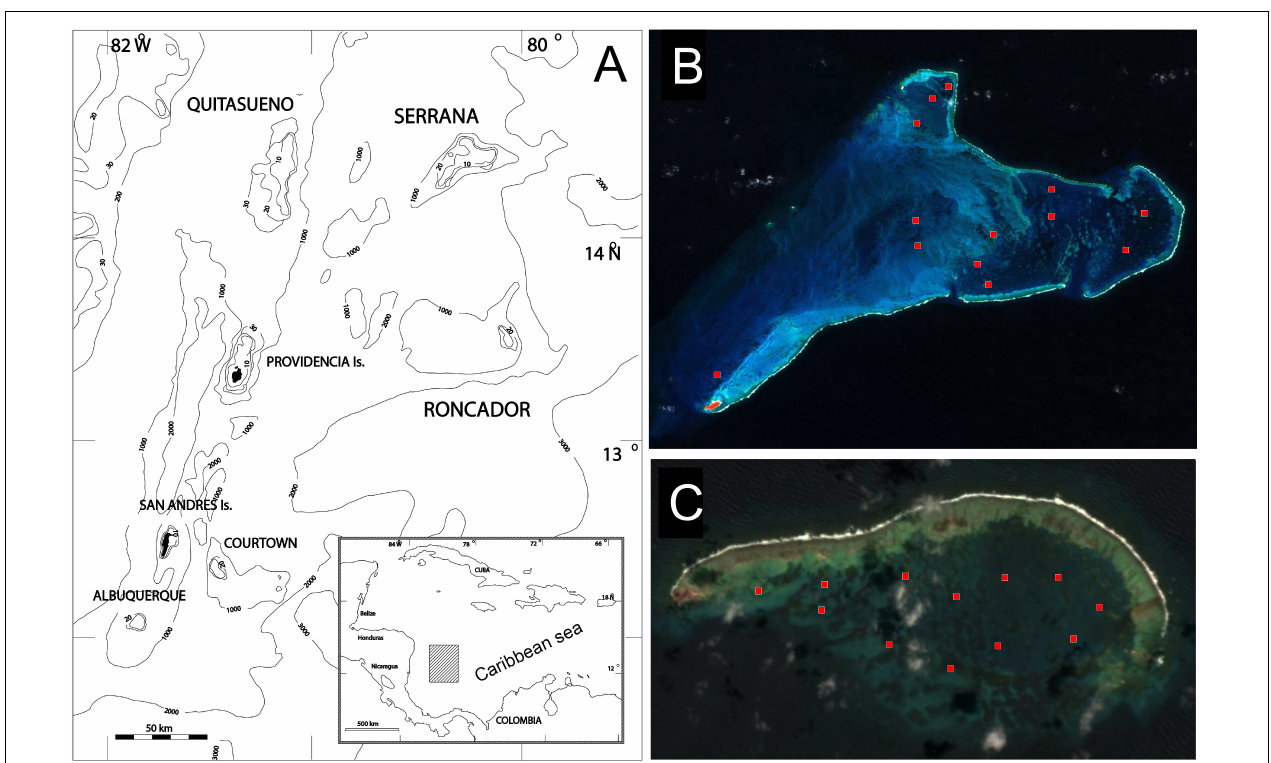
FIGURE 1 | Study area. (A) Partial map of the Southwestern Caribbean showing the geographical location of the studied Banks in the San Andrés, Providencia and Santa Catalina Archipelago (Colombia) and details of the study sites: (B) Serrana (2016) and (C) Roncador Banks (2015) (red squares, exact positions in the Supplementary Table 1 ) (Images from